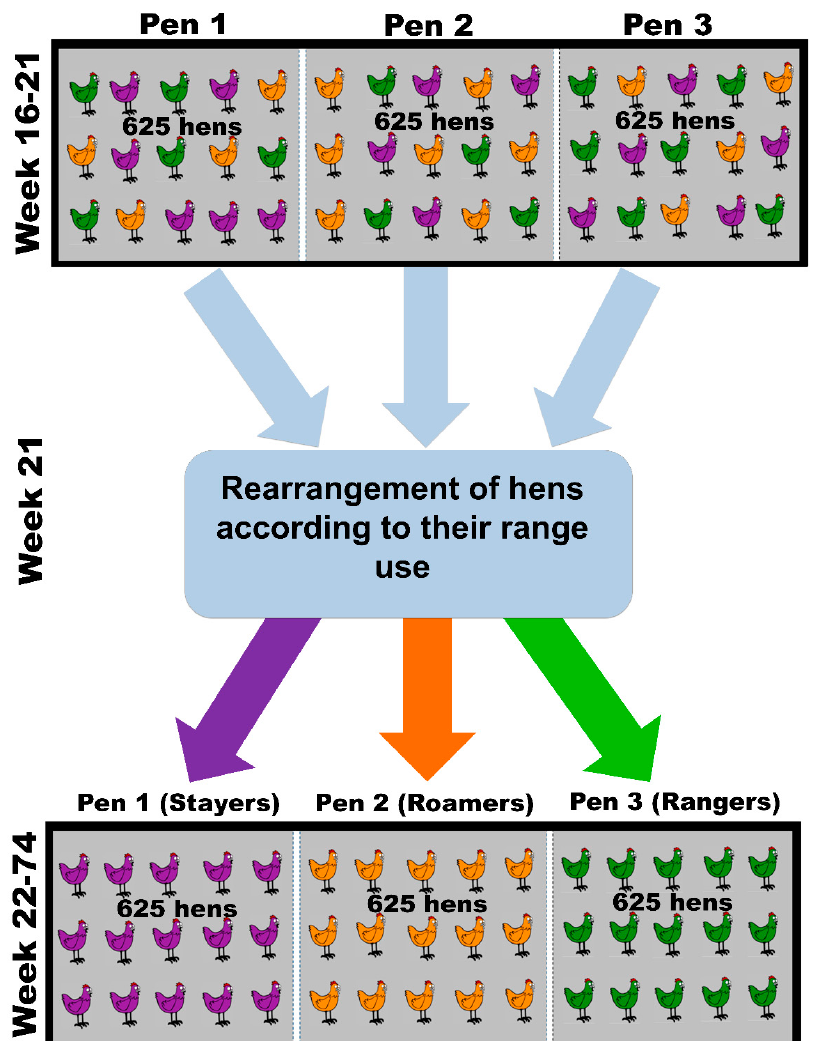
Figure 2. Rearrangement of hens according to their range use. The top part of the figure shows the composition of hens in the experimental unit sub-section after being placed when hens were 16–21 weeks of age. Because the hens were randomly selected, each sub-section contained hens that preferred to stay in the shed (“stayers”), but also hens that preferred to use the range every single day (“rangers”), or to explore occasionally (“roamers”). After the range use of these hens was monitored sub-populations that consisted of stayers, roamers and rangers only (bottom part of the figure).